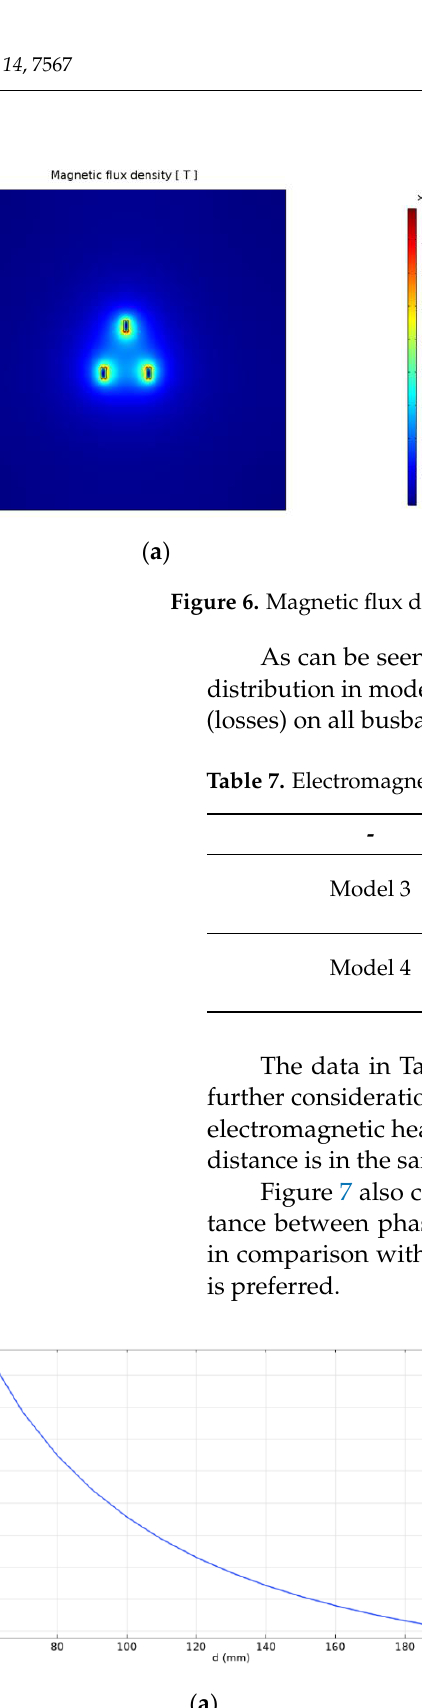
Figure 7. Electromagnetic heating against the phase-to-phase distance at 60 Hz for: ( a ) Model 3; ( b ) Model 4.